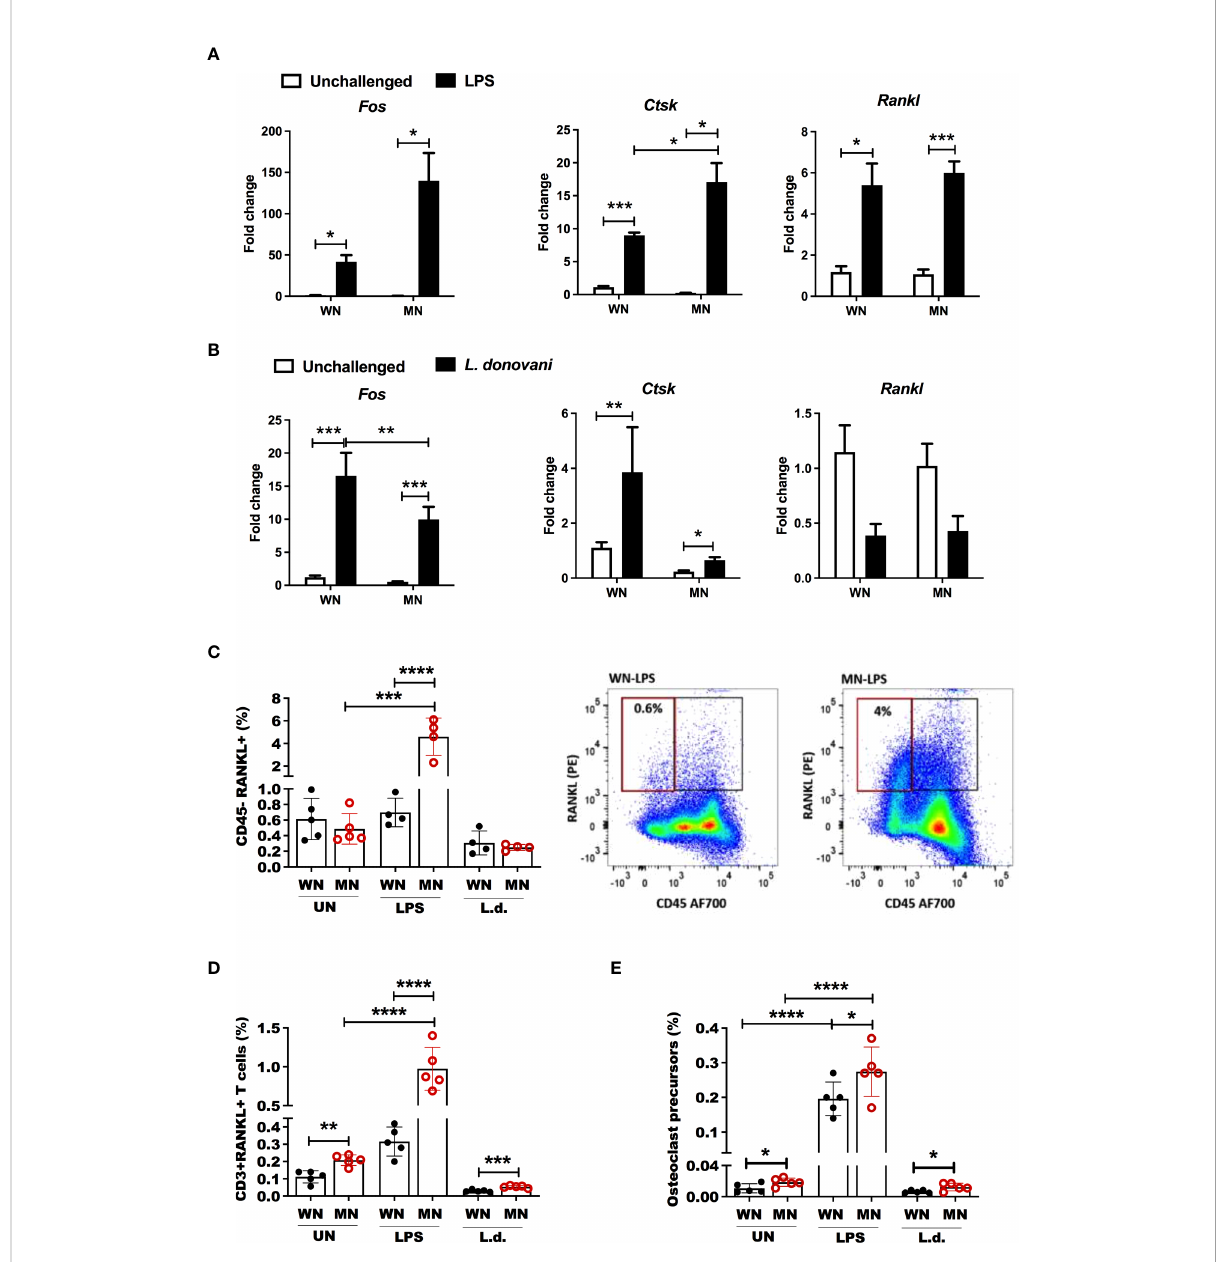
FIGURE 6 Malnutrition promotes expression of genes and cell populations associated with osteoclastogenesis following in fl ammatory challenge. (A) Expression of the osteoclast differentiation genes, Fos Proto-Oncogene ( Fos ), cathepsin ( Ctsk ) and RANK ligand ( Rankl ), in the bone marrow of well-nourished (WN) or malnourished (MN) mice that were naïve unchallenged (Un) or mice challenged with LPS. Bone marrow was obtained 24h after LPS challenge and expression determined by qRT-PCR. (B) Expression of Fos , Ctsk , and Rankl in the bone marrow of well-nourished (WN) or malnourished (MN) mice that were naïve unchallenged (Un) or challenged with L. donovani ( L.d .). Bone marrow was obtained 72 hr after Ld challenge and expression determined by qRT-PCR. (C) Percentage of bone marrow non-hematopoietic cells expressing osteoclast differentiation/activation factor Rankl (CD45- Rankl+) relative to total cells in well-nourished (WN) or malnourished (MN) mice that were naïve unchallenged (Un) or challenged with LPS or L. donovani ( L.d .). Bone marrow from LPS-challenged mice was obtained at 24h post-challenge and L. donovani -challenged mice at 72h post-challenge determined by fl ow cytometry. Right: representative dot-plot showing percentage of CD45-RANKL+ cells (gated as S Figure 1B). (D) Percentage of T cells expressing RANKL (CD3+RANKL+) in the bone marrow using fl ow cytometry (gated as S Figure 1C). (E) Percentage of bone marrow osteoclast precursors (CD45-CD115+ cKIT+) relative to total bone marrow cells in in well-nourished (WN) or malnourished (MN) mice that were naïve unchallenged (Un) or challenged with LPS or L. donovani ( L.d .) determined by fl ow cytometry (gated as S Figure 1D). N=5 mice per group, 2 experiments. *p<0.05, **p<0.01, ***p<0.001,